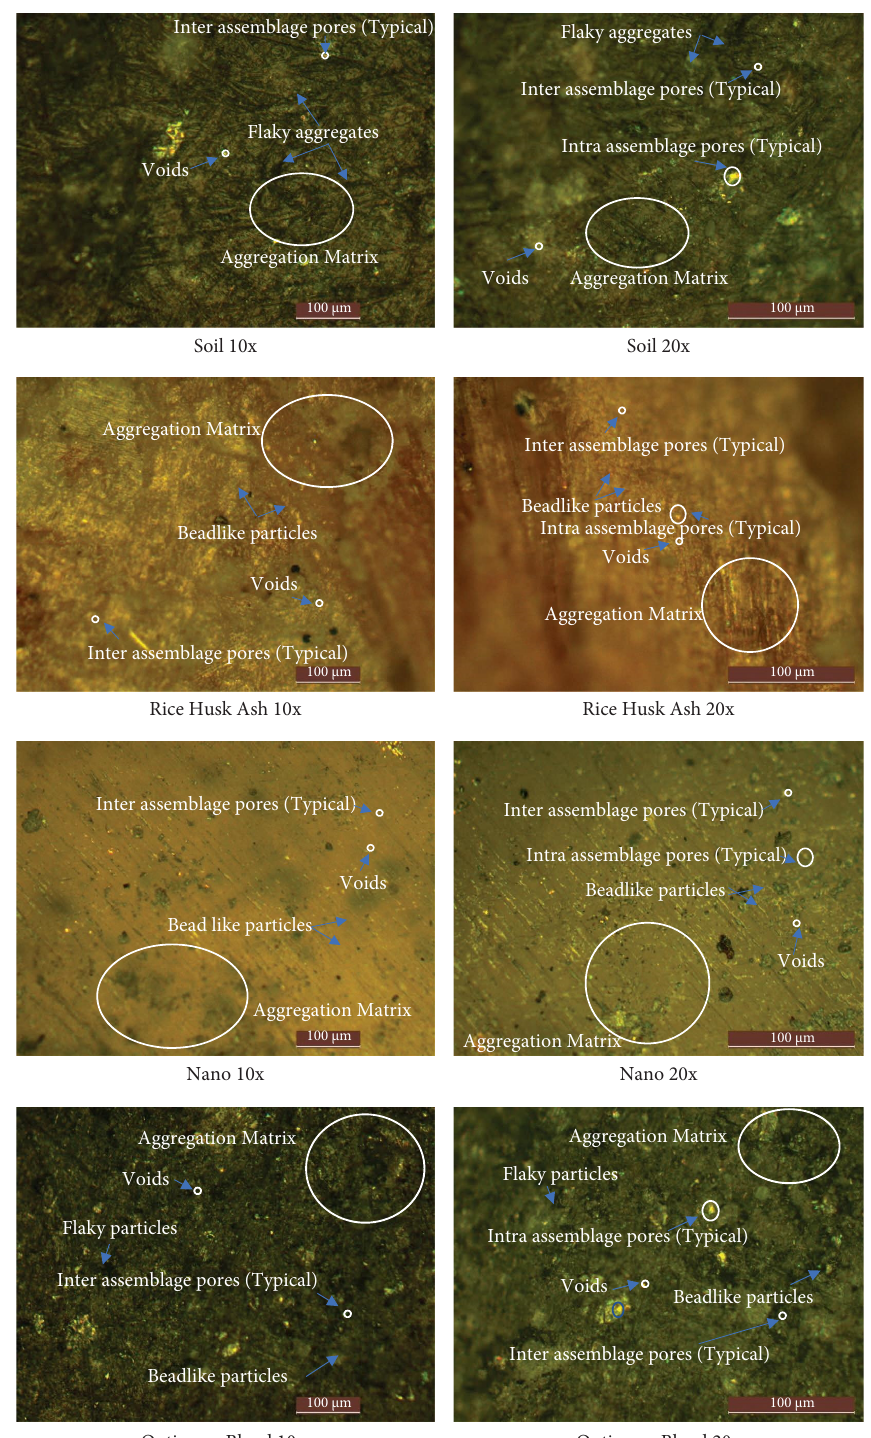
Figure 10: Optical microscopic